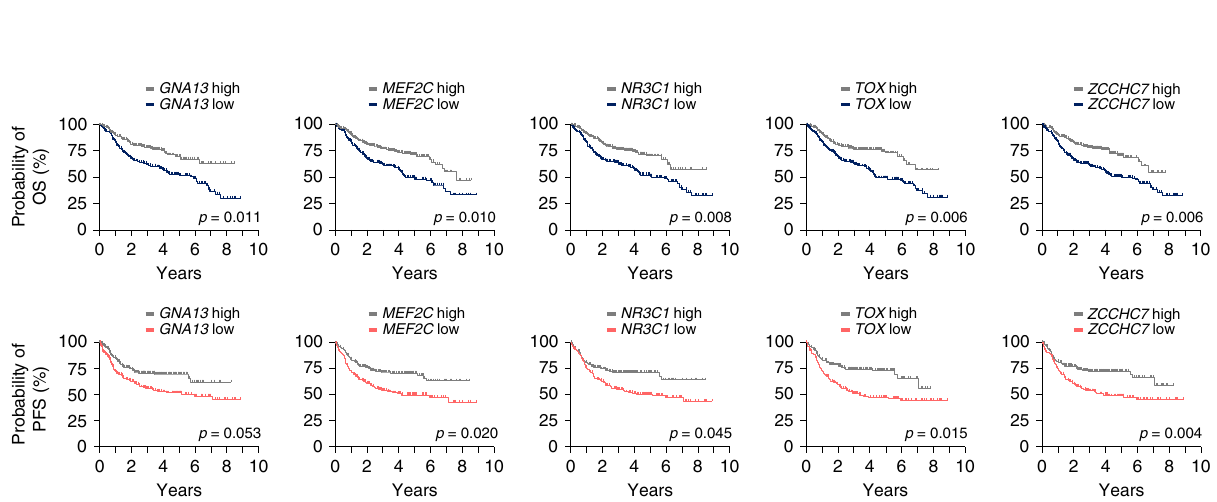
Fig. 8 Clinical relevance of CIS genes in human DLBCL. Association of CIS genes with overall and progression-free survival in a large clinically annotated DLBCL patient cohort ( n = 424; GSE31312). For each of the 50 CIS genes, the cohort was strati fi ed into "low" (LE; below median expression) or "high" expression (HE, above median). Kaplan – Meier plots for the top fi ve genes, for which associations (between low gene expression and poor survival) were also observed in a second DLBCL patient cohort ( n = 220; GSE10846), are shown. The signi fi cance threshold was set to a false discovery rate of 0.05. For genes, for which multiple probes were available, the one giving the signal with the highest variance was selected. Association with overall survival (OS) is shown on the top, and association with progression-free survival (PFS) on the